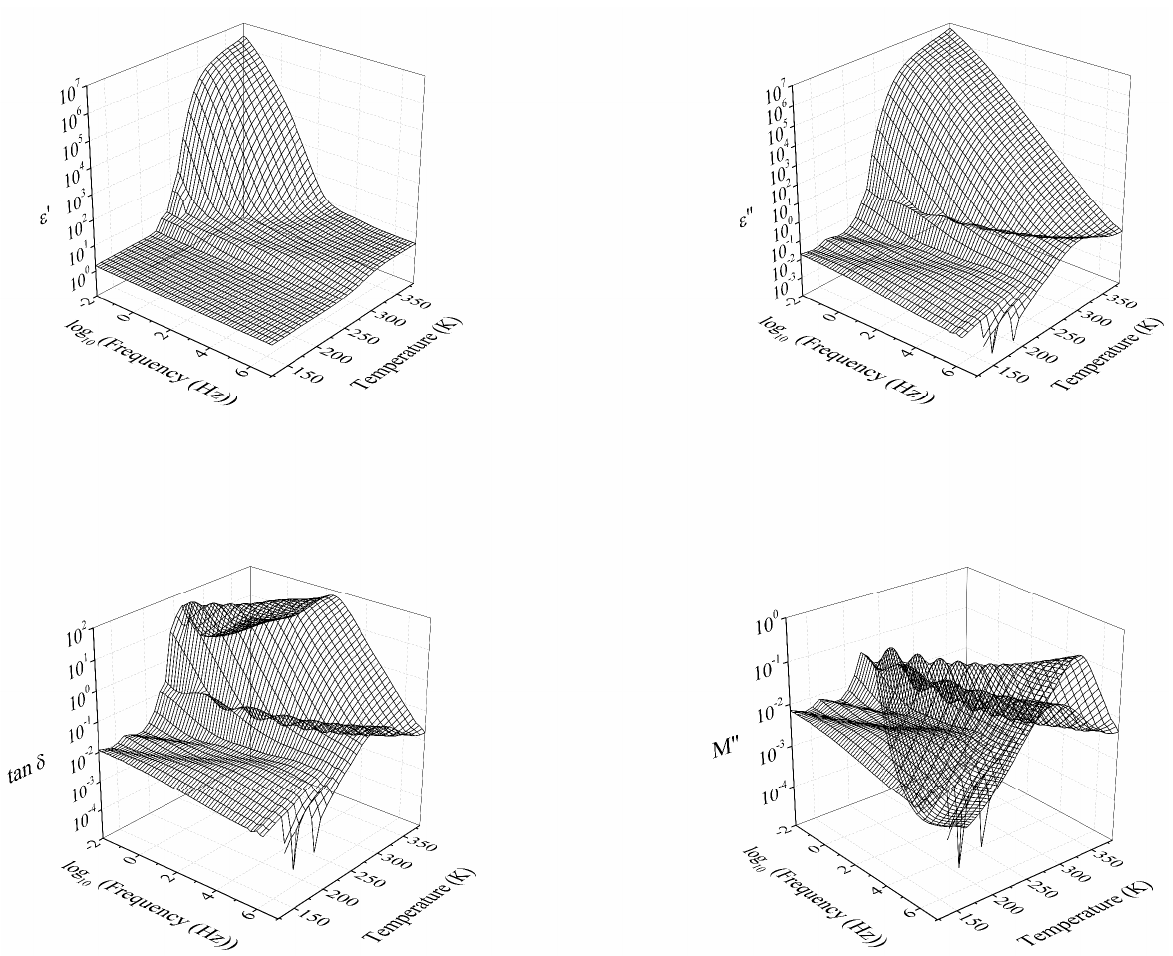
Figure 2. Three-dimensional plot of the dielectric spectra of the CP0 in terms of the real part of the dielectric permittivity ( ε ’ ), the imaginary part of the dielectric permittivity ( ε ” ), the loss tangent (tan δ ), and the imaginary part of the complex electric modulus ( M” ).